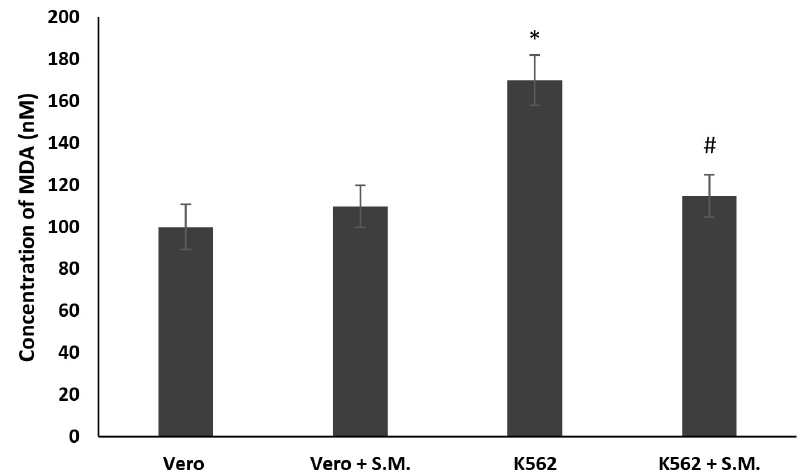
Figure 3. Lipid peroxidation inhibitory activity in K562 cells and Vero cells treated with Skeletonema marinoi (S.M.) for 48 h at a concentration of 0.75 mg/mL. Data are expressed by the means ± standard deviation (SD) of three experiments. (* p < 0.05 means a significant difference between the Vero and K562 cells; # p < 0.05 means a significant difference between the treated and untreated K562 cells).